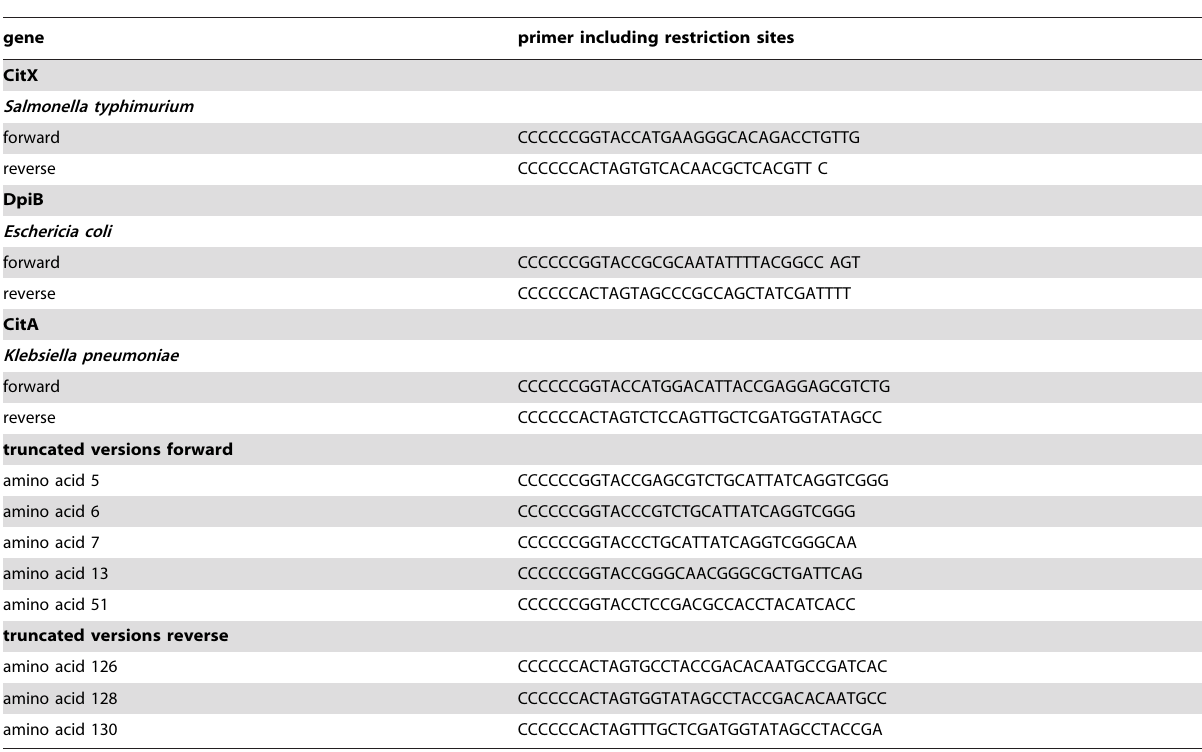
Table 2. Primers used for construction and engineering of sensor